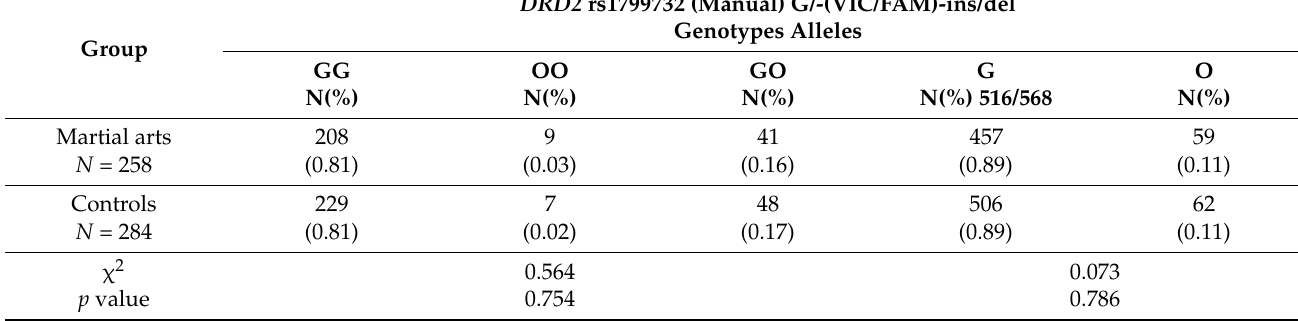
Table 2. Frequency of genotypes and alleles of the DRD2 rs1799732 (manual) G/ − (VIC/FAM)-ins/del polymorphism group of martial arts subjects and